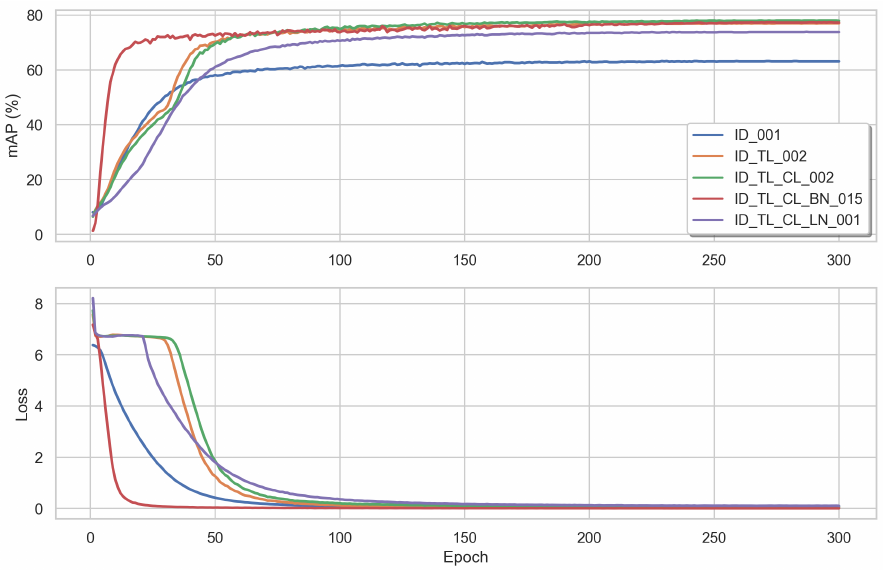
Figure 11. The mAP score (%) and training loss per epoch using different loss functions and learn- ing rates: L ID and LR = 1.0 × 10 − 3 (blue), L ID , L tri and LR = 2.0 × 10 − 3 (yellow), L ID , L tri , L cen and LR = 2.0 × 10 − 3 (green), L ID , L tri , L cen , BNNeck and LR = 2.0 × 10 − 3 (red), and LNNeck and LR = 1.0 × 10 − 3 (purple).